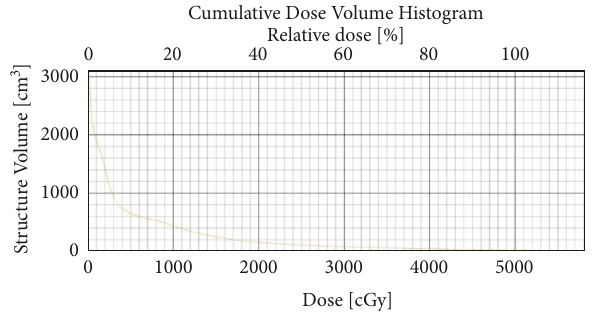
Figure 7: DVH showing total lung minus target dose for patient